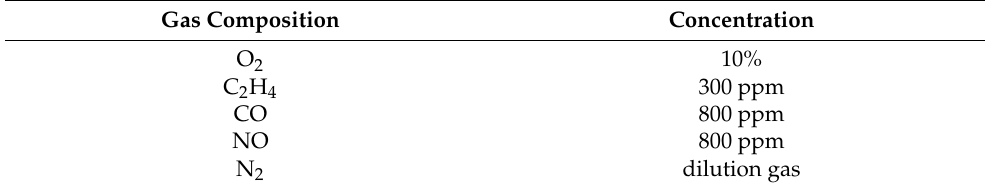
Figure 4. Simulation test flow chart.